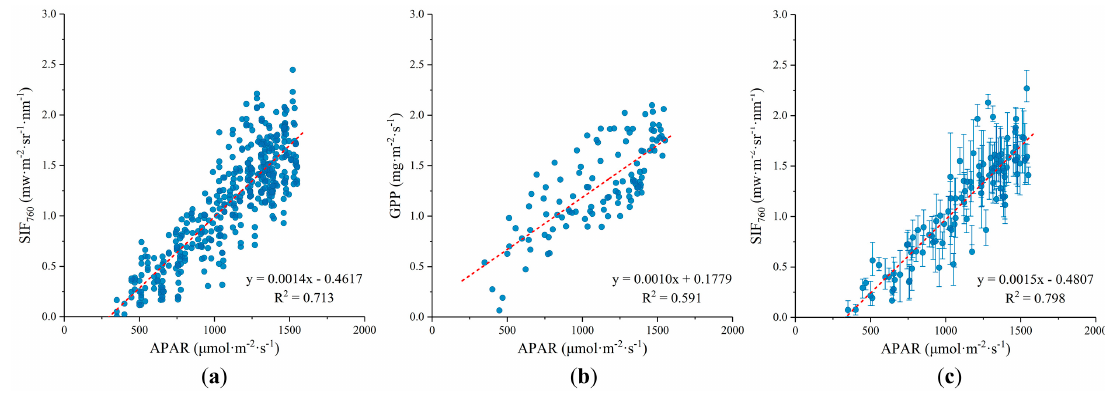
Figure 4. Relationship between APAR (absorbed photosynthetically active radiation) and: ( a ) individual SIF 760 ; ( b ) GPP; and ( c ) averaged SIF. The error bar indicates the range of SIF 760 values for four measurements.